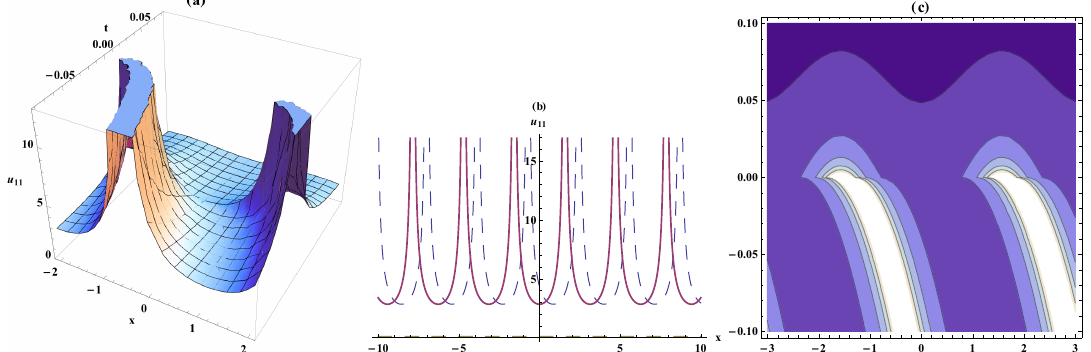
Figure 10. Solitary wave, the bistable wave amplitude, and contour plots for Equation (84). On the respective interval { x , − 2.05,2.05 } , { t , − 0.08,0.08 } , { x , − 10,10 } , { t , − 1,1 } , { x , − 3,3 } , { t , − 0.1,0.1 }